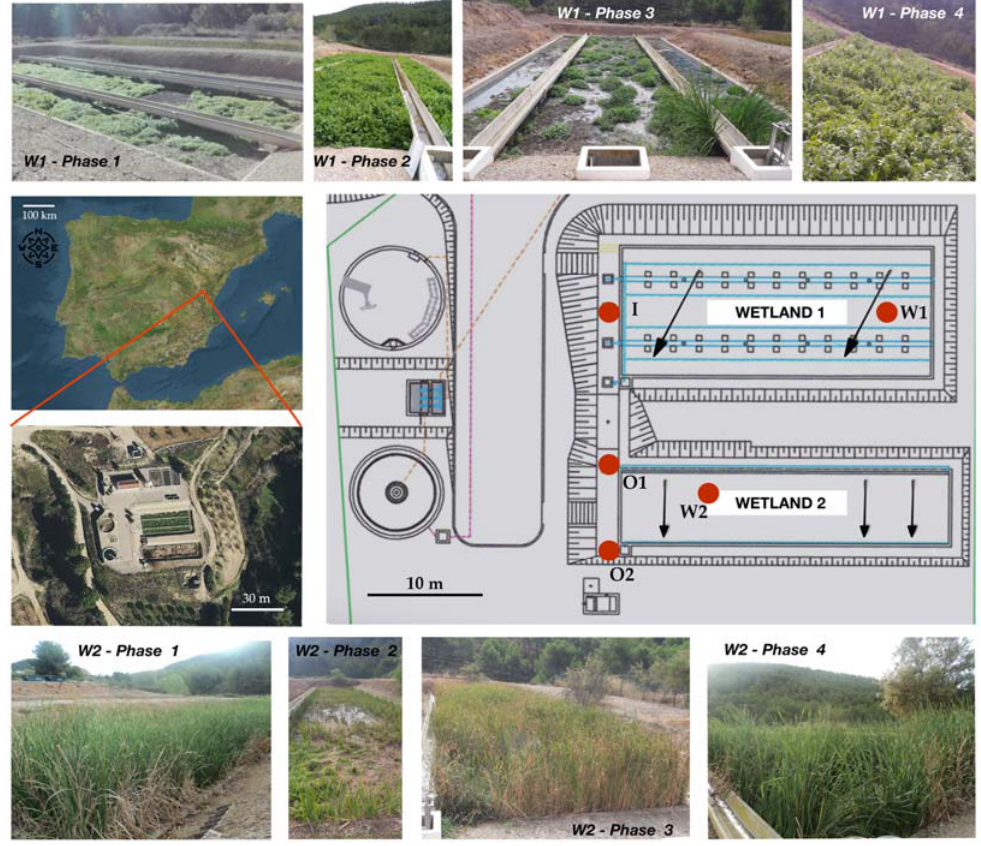
Figure 1. Map with the location of the studied system, design of the waste water treatment plant (WWTP) and the associated constructed wetlands, and photographs of the vegetation coverage during different phases of the study of Wetland 1, covered by Helosciadum nodiflorum , and Wetland 2, covered by Typha latifolia . Red dots indicate the respective sampling points for the inlet to Wetland 1 (I), Wetland 1 (W1), the outlet from Wetland 1 entering Wetland 2 (O1), Wetland 2 (W2), and the outlet from the constructed wetland system (O2).